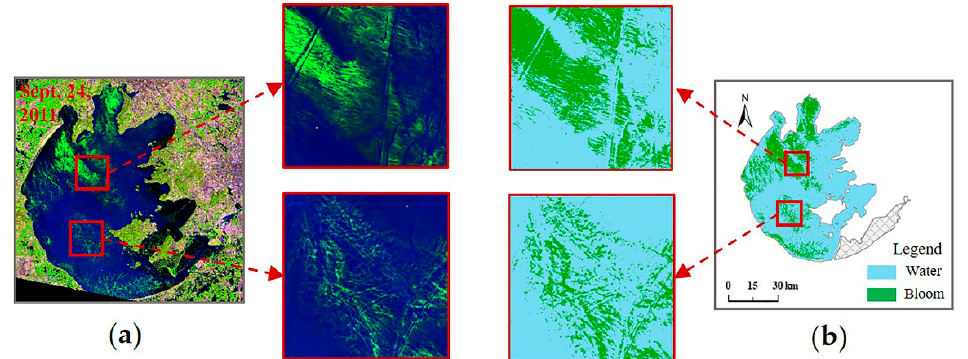
Figure 6. Validation of the support vector machine (SVM) method used to detect the algal blooms. ( a ) Landsat-7 image acquired on 24 September 2011. ( b ) Supervised classification results for the algal bloom obtained by SVM.